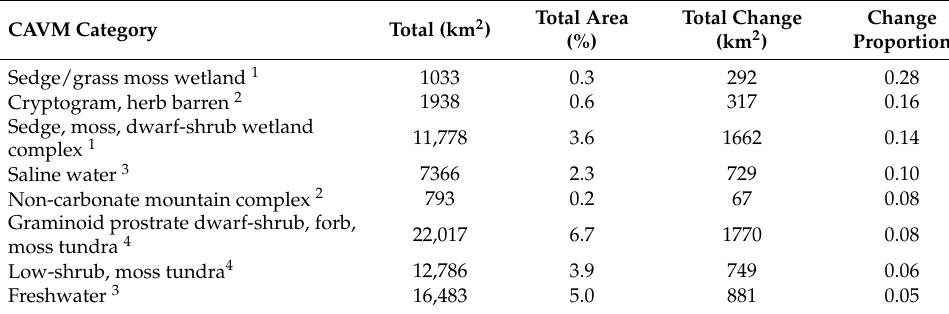
Table A2. Total area and change among vegetation and land cover categories defined by the circumpolar arctic vegetation map (CAVM)